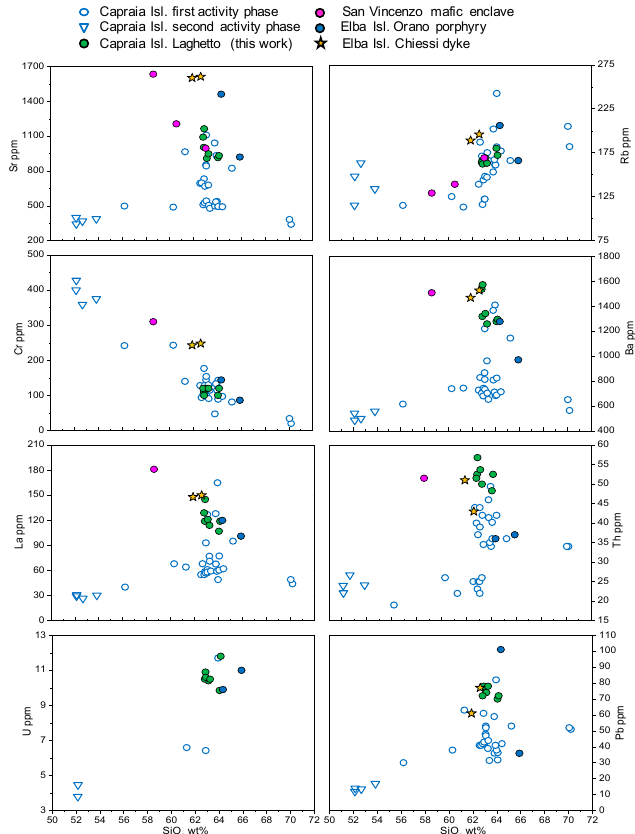
Figure 6. Trace element variation diagrams for Capraia rocks.